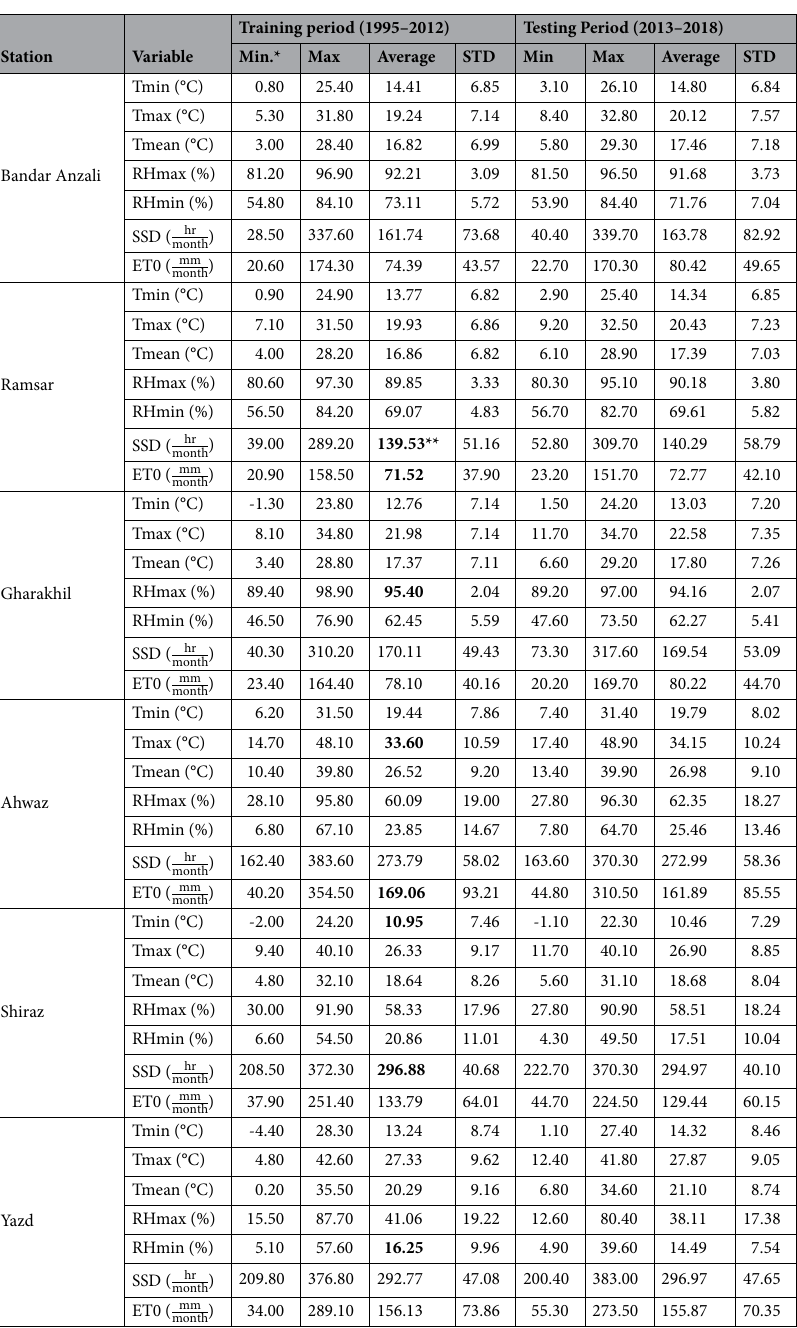
Table 2. Specifications of the meteorological data used and the calculated ET0 on the monthly scale. *Min. = Minimum; Max. = Maximum; STD = Standard deviation. **The rows bolded in this comment, show the extreme values of the variable. For example, the minimum values of Tmin and RHmin, belong to the Shiraz and Yazd stations, respectively. Or the maximum values of Tmax and RHmax, belong to the Ahwaz and Gharakhil stations, respectively. For the variables SSD and ET0, both minimum (Ramsar) and maximum values (Shiraz and Ahwaz) are